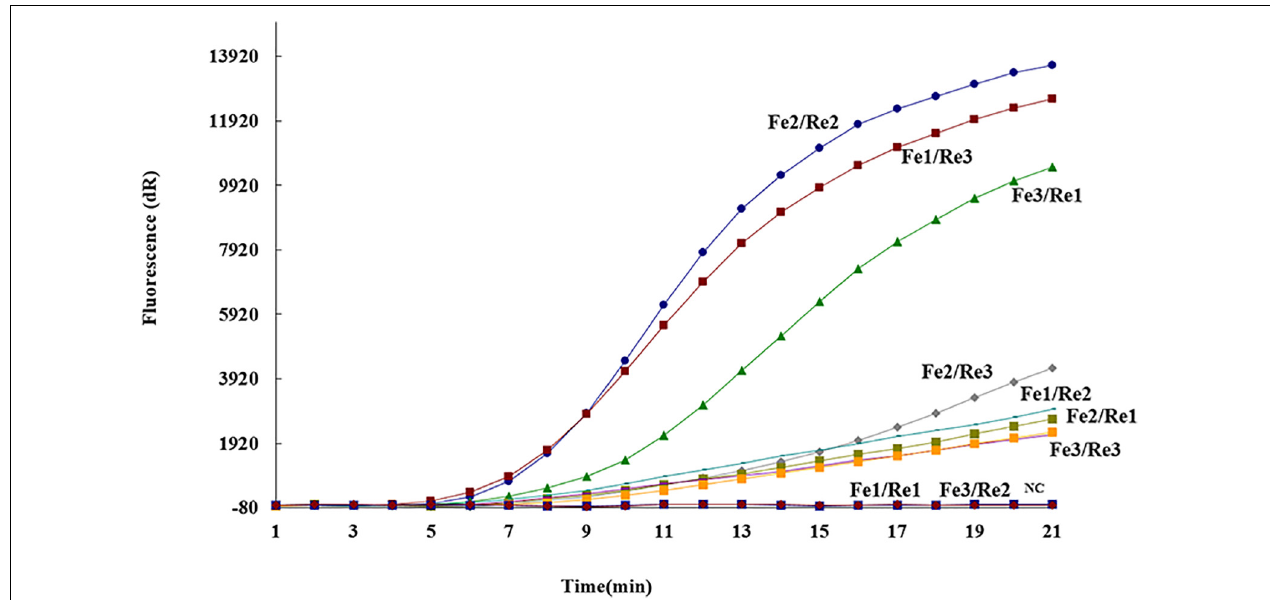
FIGURE 1 | Optimal primer and probe combinations for the real-time recombinase-aid amplification (RAA) assay. Three forward primers (ASFV Fe1–Fe3), three reverse primers (ASFV Re1–Re3), and one probe (ASFV Pe) were used to select the best combination. NC , negative control.